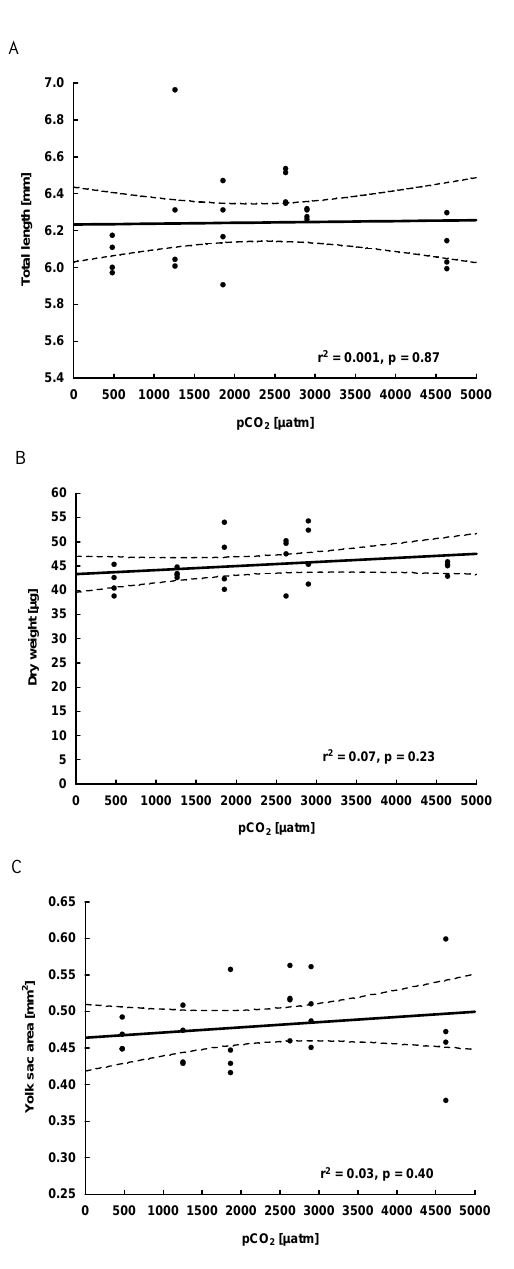
Fig. 3. (A) Total length, (B) dry weight and (C) yolk sac area of newly hatched Atlantic herring larvae as a function of p CO 2 (4 replicates per treatment level). Data points are mean values of 6 individual larvae. The solid line shows the regression line, whereas the dashed lines represent the 95% confidence intervals. (A) The r 2 and P -value were derived from log-transformed data.